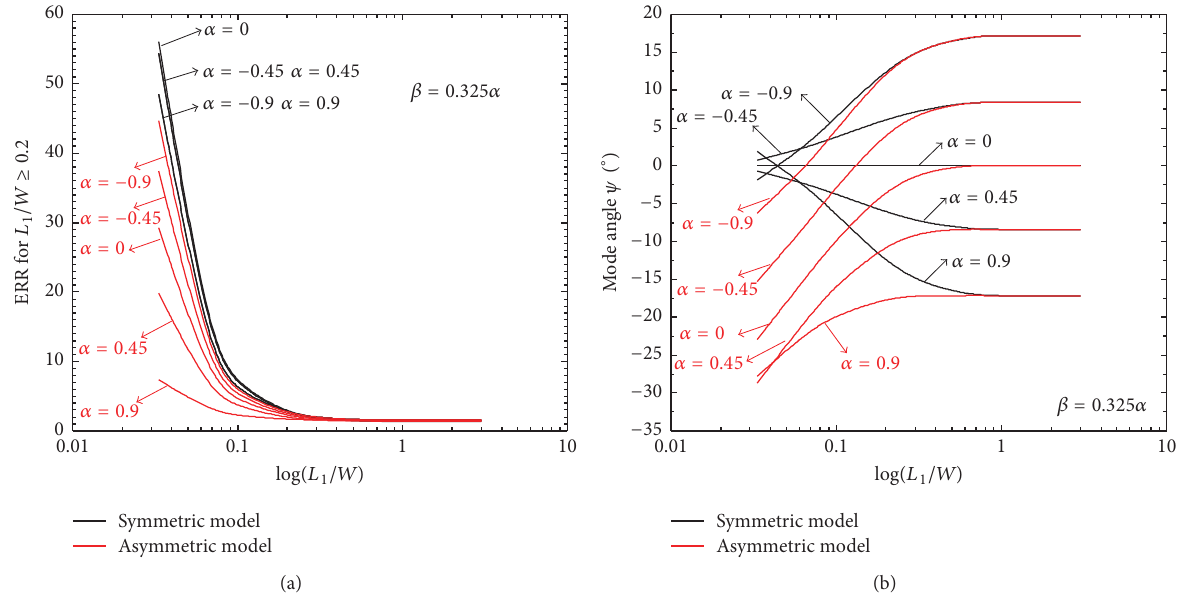
Figure 12: Variations of (a) normalized ERR 𝐺𝐸 ∗ /(𝜎 2 𝜋𝑎) and (b) mode angle 𝜓 against logarithmic 𝐿 1 /𝑊 .